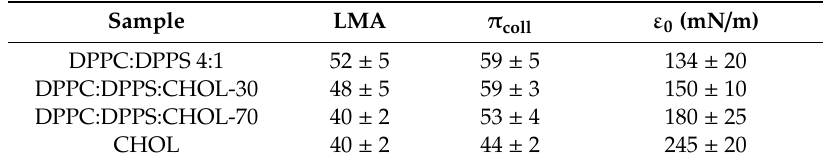
Table 2. Limiting molecular area LMA, collapse pressure ( π coll ), and maximum Gibbs elasticity ( ε 0 ) values of DPPC:DPPS:CHOL monolayers spread onto NaCl 15 mM (Figure 1A).